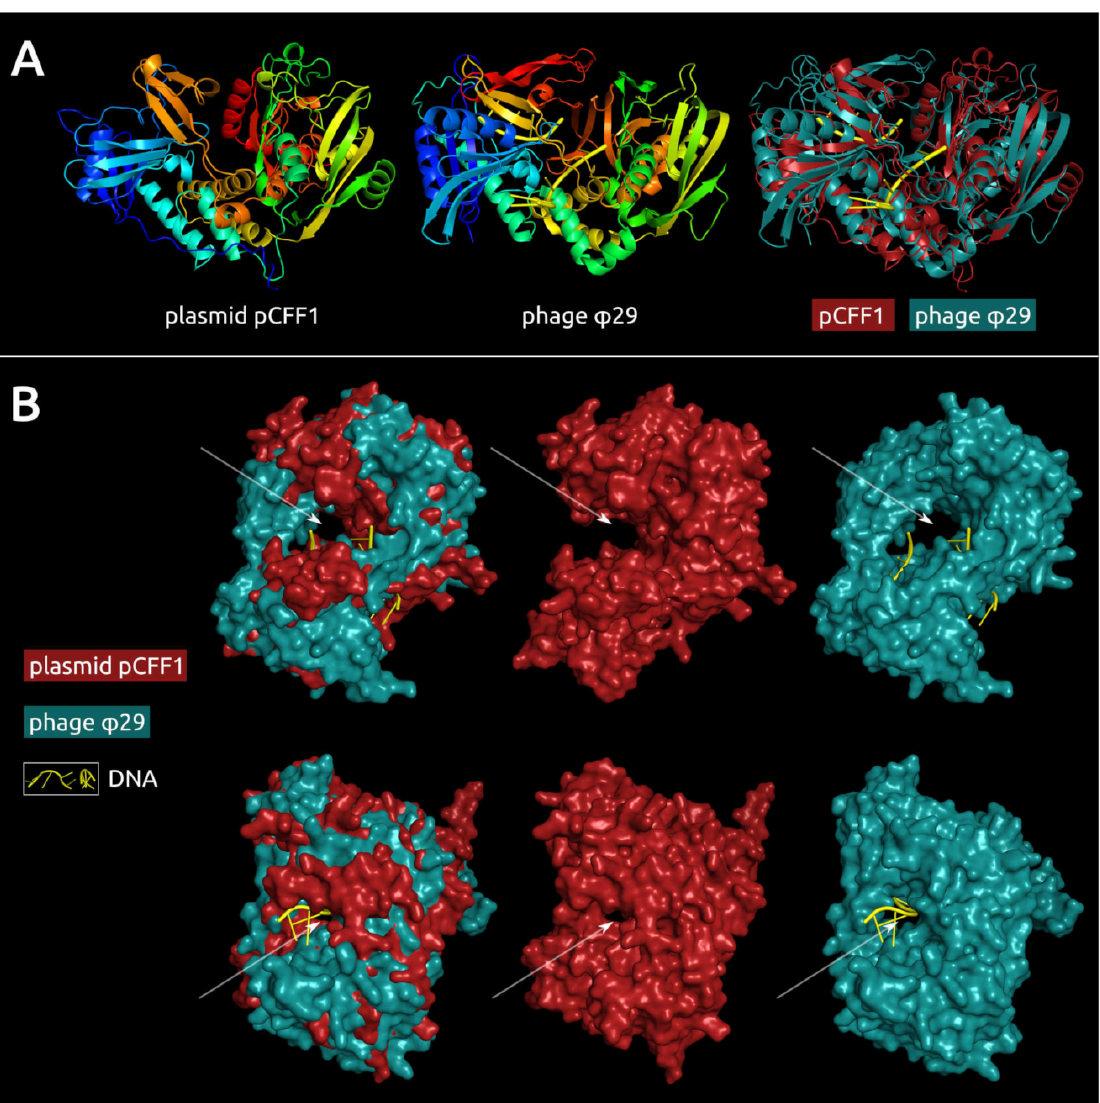
Figure 8. ( A ) Predicted structure of putative DNA polymerase from C. fpf P990 plasmid pCff1, the experimentally found structure of Bacillus phage ϕ 29 DNA polymerase B complexed with DNA (PDB structure 2PY5) and their superimposition (RMSD 5.8 Å). The models are coloured based on a rainbow gradient scheme, where the N-terminus of the polypeptide chain is coloured blue, and the C-terminus is coloured red. ( B ) Superimposition of the predicted structure of putative DNA polymerase from plasmid pCff1, the predicted structure of pCff1 putative DNA polymerase and the experimentally found structure of ϕ 29 DNA polymerase complexed with DNA using the protein surfaces. The arrows indicate the presence of similarly located cavities and tunnels in both